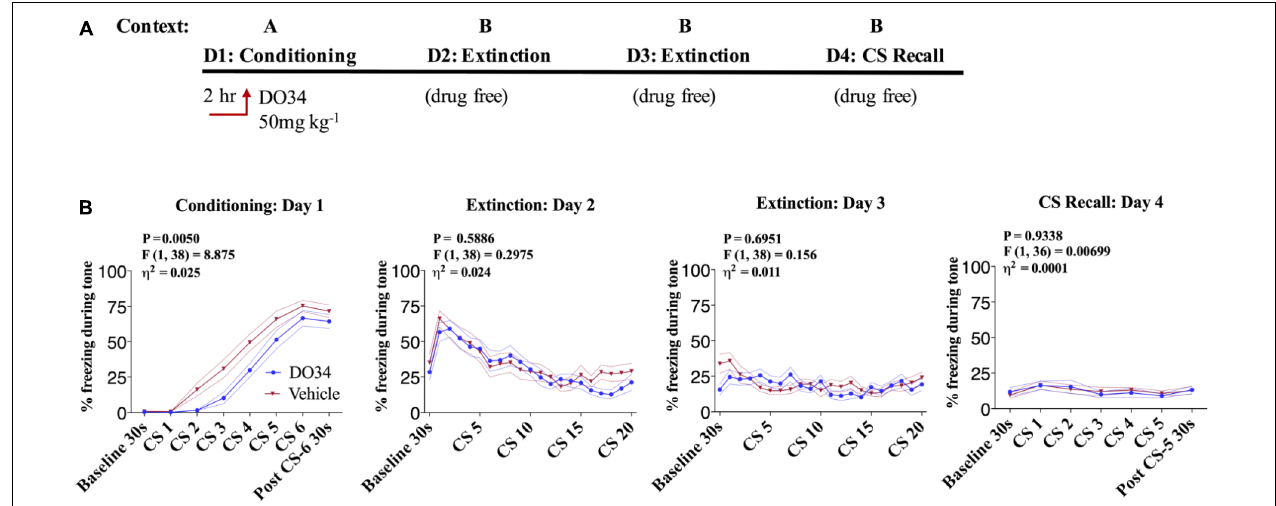
FIGURE 2 | Pharmacological DAGL inhibition does not affect acquisition of conditioned-fear. (A) Schematic diagram of the experimental paradigm. (B) (Far left panel) % freezing by C57BL/6J male mice during acquisition of cue-conditioned fear when DO34 (50 mg kg − 1 ) was injected IP 2 h prior to trial. (Middle panels) % freezing during auditory cue during extinction training days 2 and 3. (Far right panel) % freezing during extinction recall ( n = 20 male mice per condition). F - and P -values and η 2 for main effect of drug treatment show in each panel. All values are presented as mean ±